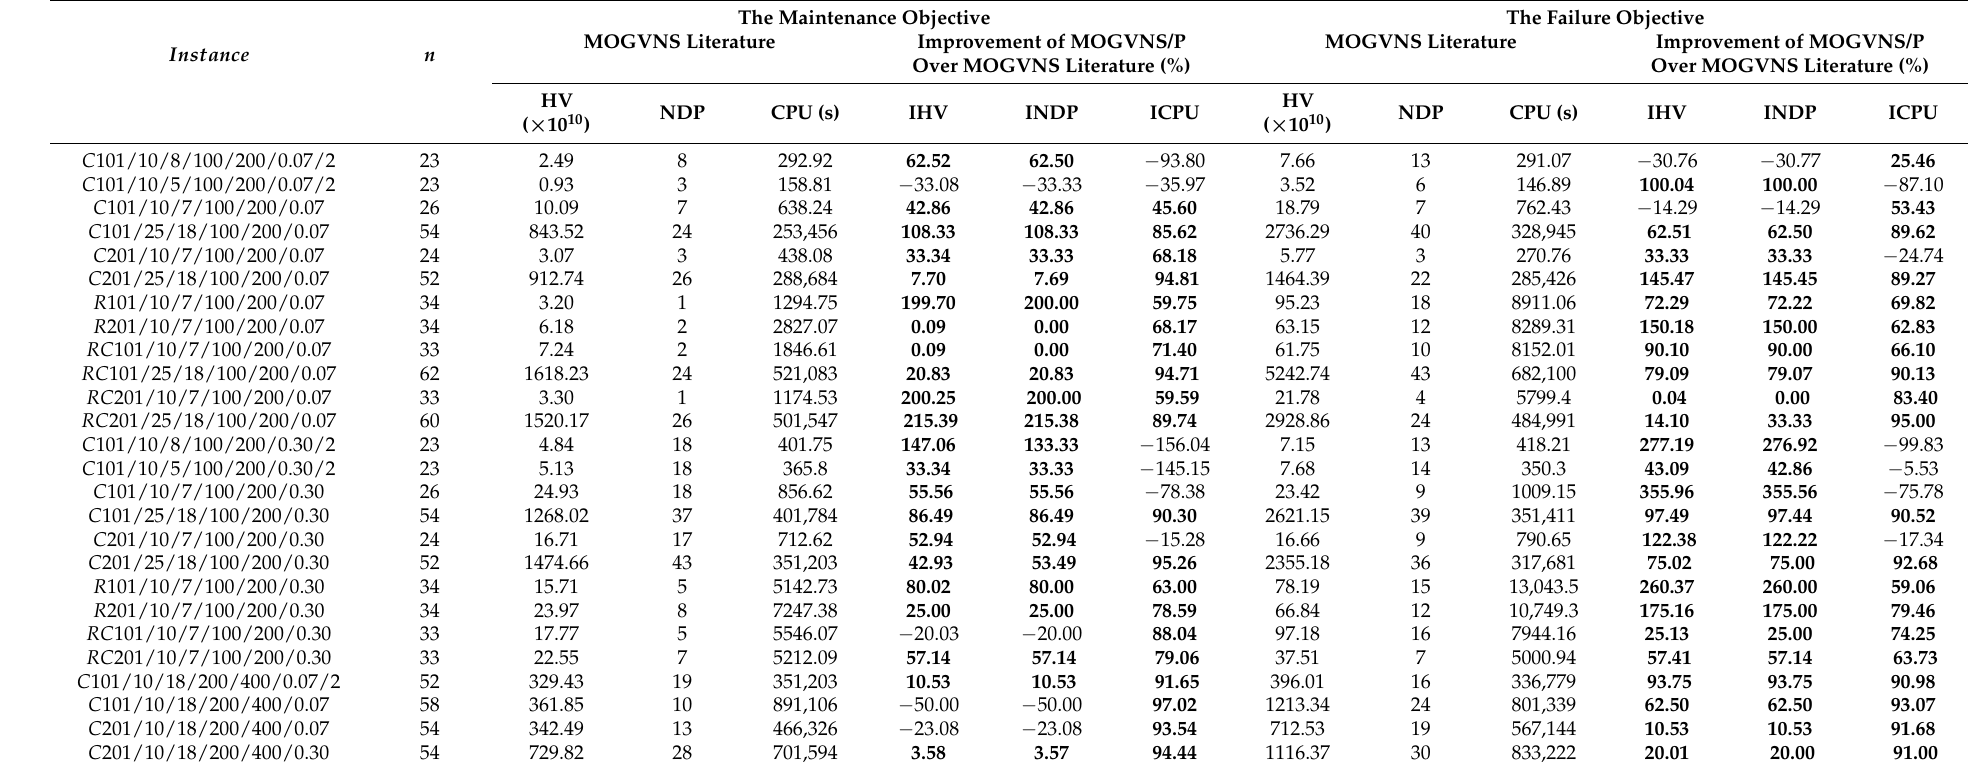
Table A3. Results of MOGVNS literature and improvement of MOGVNS/P over the MOGVNS of the literature